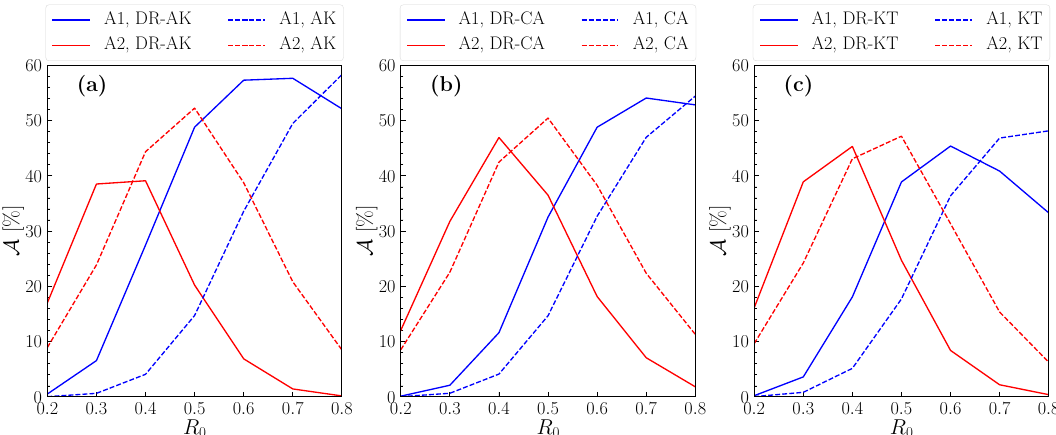
Figure 6 . The variation of acceptance efficiency A [eq. (3.1)] as a function of starting radius R 0 for pp → tj SM process. The blue and red lines represent the variations of A for categories A1 and A2 events, respectively. The dashed lines are for (a) AK, (b) CA, and (c) KT algorithm and the solid lines are for their dynamic radius